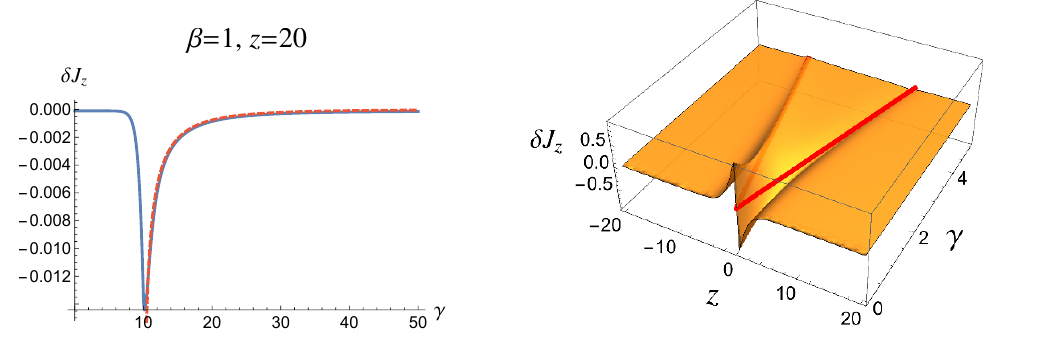
(cid:16) (cid:17) h ^ J z i (cid:12) (cid:0) h ^ J z i 0 (solid-blue) and h ^ J z i low (dashed-